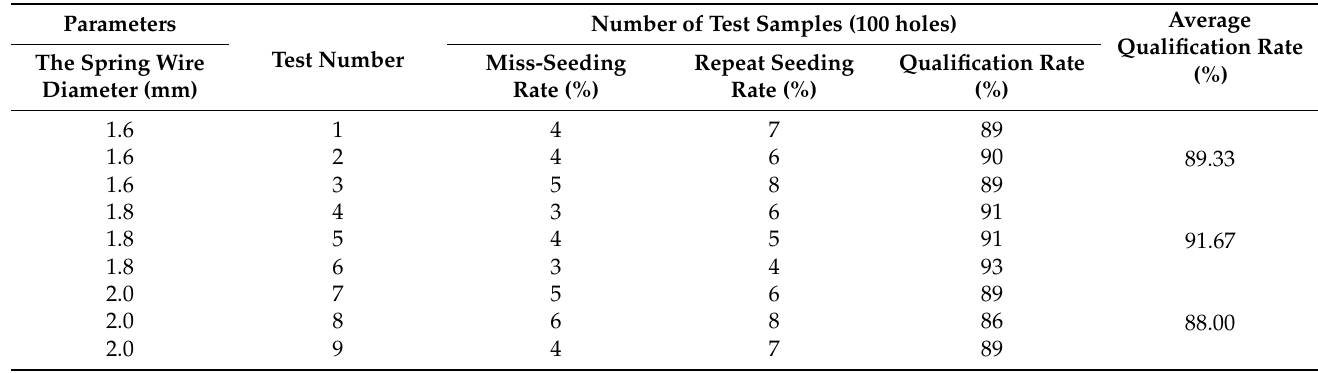
Table 3. Statistical table of bench test qualification rate.